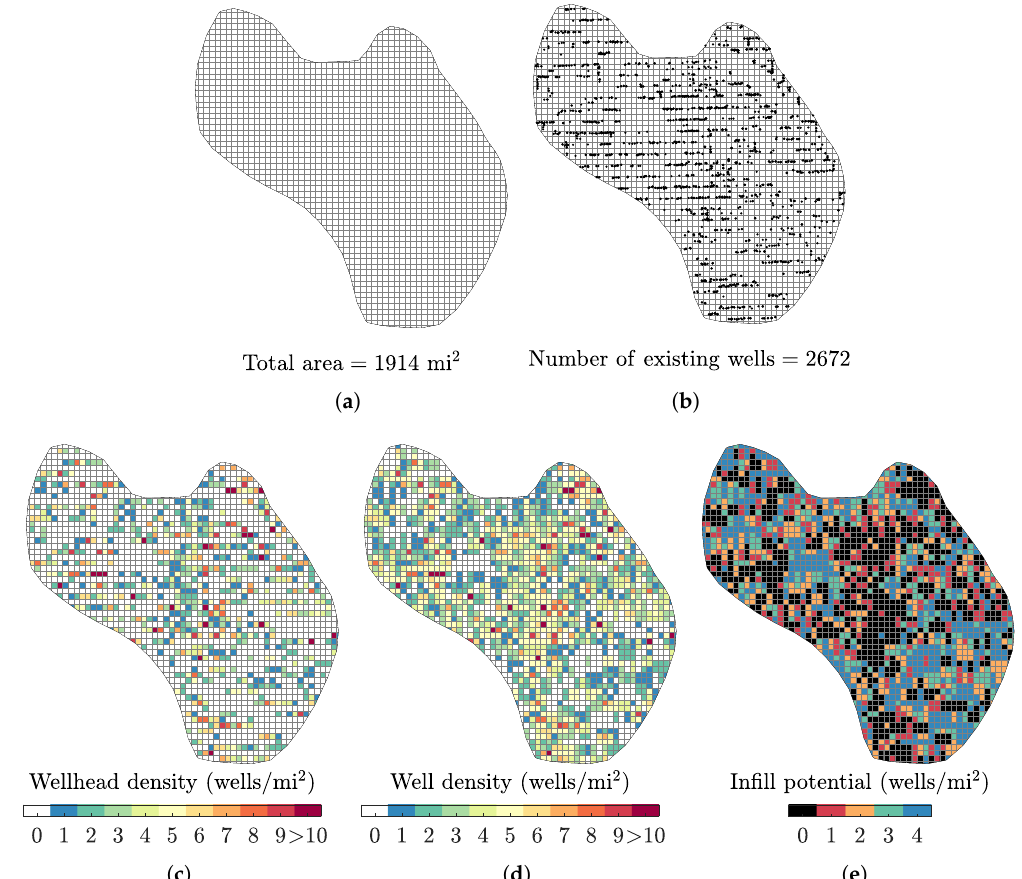
Figure 8. A procedure to calculate infill well potential for each part of the Bakken play. This figure shows only the Three Forks core area. For other areas and reservoirs, please see the Supporting Online Materials. The procedure is as follows: ( a ) Create a one-square-mile fishnet inside the boundary of each area. In this case, there are 1914 grid squares that translate into the total area of 1914 mi 2 . ( b ) Search all existing wells located inside the boundary. The black dots show the surface locations of 2672 existing wells in Three Forks core area. ( c ) Calculate wellhead density by counting the number of wells on each of the one-square-mile squares. This map is not the real well density map, because it only shows the wellhead density. ( d ) Calculate an approximate well density map from wellhead density map. The algorithm is as follows: (1) For each well, record its lateral length and calculate the number of squares, n , intercepted by the lateral. For example, a 5000 ft lateral will occupy one square and a 10,000 ft lateral will occupy two squares because one mile is 5280 ft. (2) Search for the least occupied n squares in all possible directions (i.e., north, northeast, east, southeast, south, southwest, west and northwest). (3) Increase the value of well density by 1 well/mi 2 for every least dense square found. (4) Repeat the process until all wells in the area of interest are exhausted. ( e ) Calculate an infill potential map by subtracting the calculated well density from the maximum number of wells, N max (e.g., N max = 4 wells/mi 2 to avoid frac hits). The summation of all values in the map is the infill potential for the one-square-mile grid. In this case, we obtain 3650 wells. As most wells have 10,000 ft laterals and occupy two one-square-mile squares, we divide 3650 by 2 to obtain 1825 infill potential wells in the Three Forks core